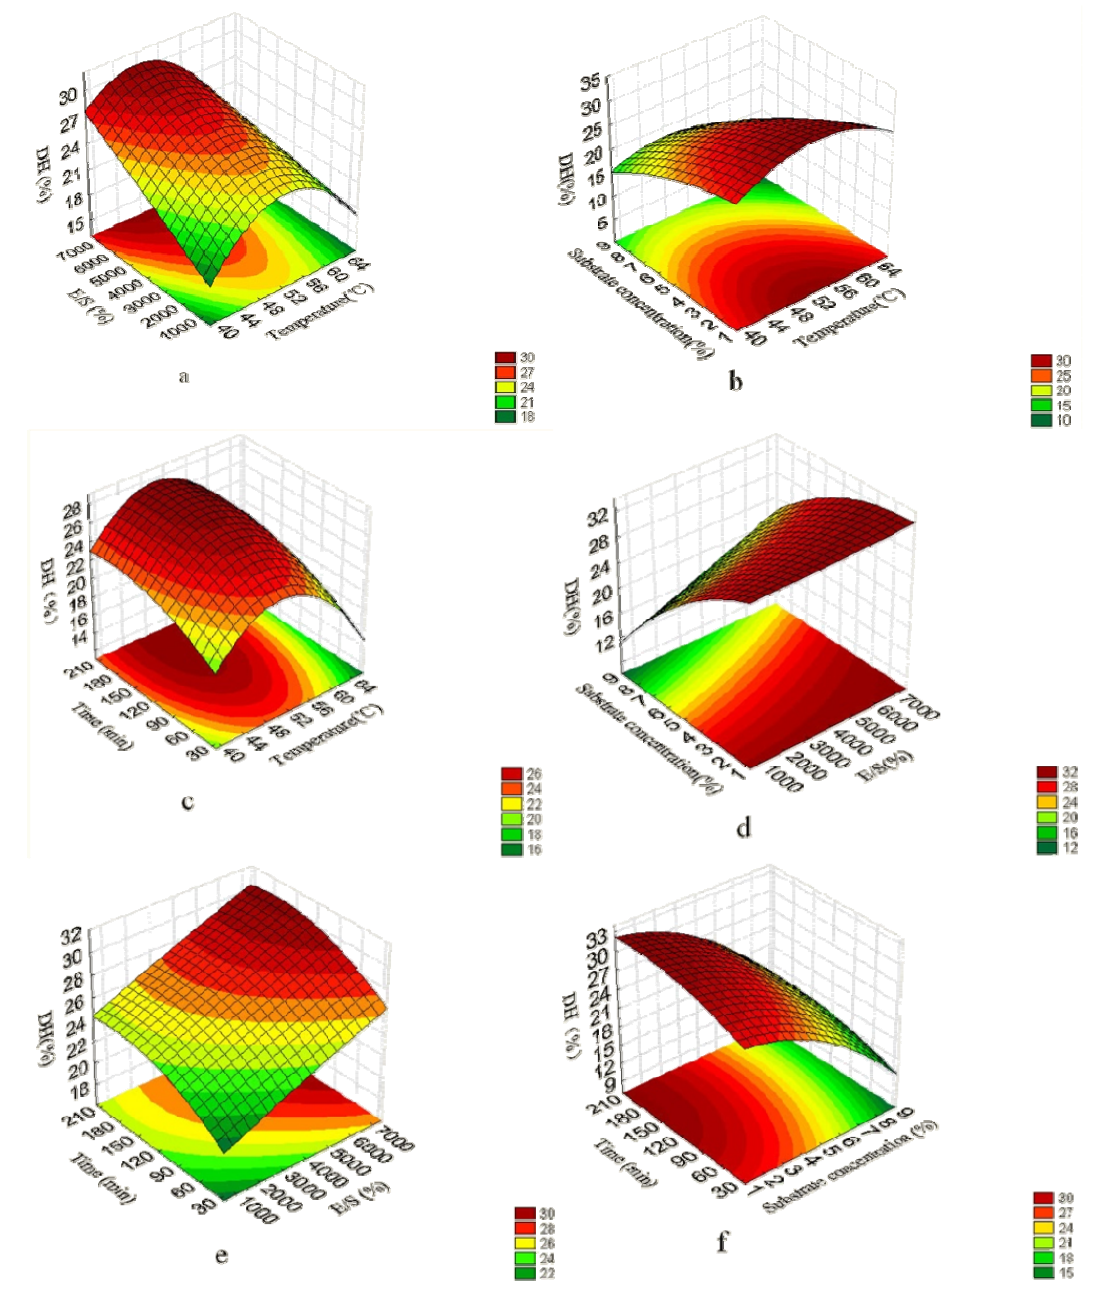
Figure 1. Response surfaces for the interaction of variables on DH. The response surface plots at various ( a ) temperatures and E/S; ( b ) temperatures and substrate concentrations; ( c ) temperatures and reaction times; ( d ) E/S and substrate concentrations; ( e ) E/S and reaction times; and ( f ) substrate concentrations and reaction